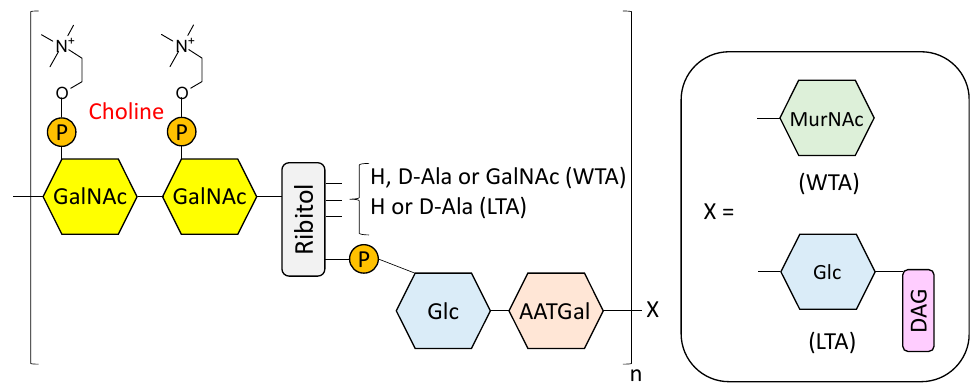
Figure 1. Structural model of pneumococcal cell wall teichoic (WTA) and lipoteichoic (LTA) acids according to Seo et al. [26] and subsequently refined by Gisch et al. [27]. GalNAc, N -acetylgalactosamine; P, phosphate group; Glc, glucose; AATGal, 2-acetamido-4-amino-2,4,6-trideoxygalactose; MurNAc, N -acetylmuramic acid; DAG, diacylglycerol. The P-Cho groups present in the TA of the pneumococcal envelope are involved in several